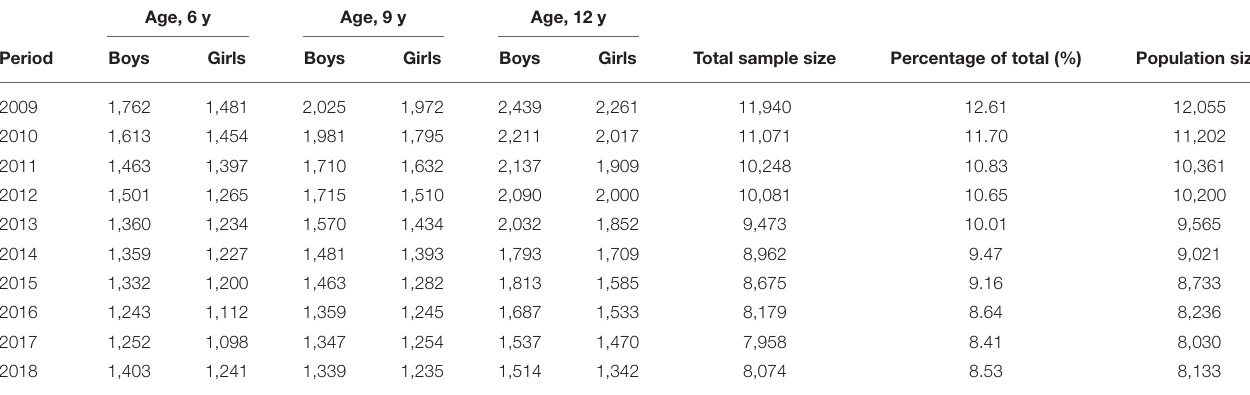
TABLE 1 | Sample sizes based on age and gender at each examination year ( n = 94,661). Age, 6 y Age, 9 y Age, 12 y Period Boys Girls Boys Girls Boys Girls Total sample size Percentage of total (%) Population